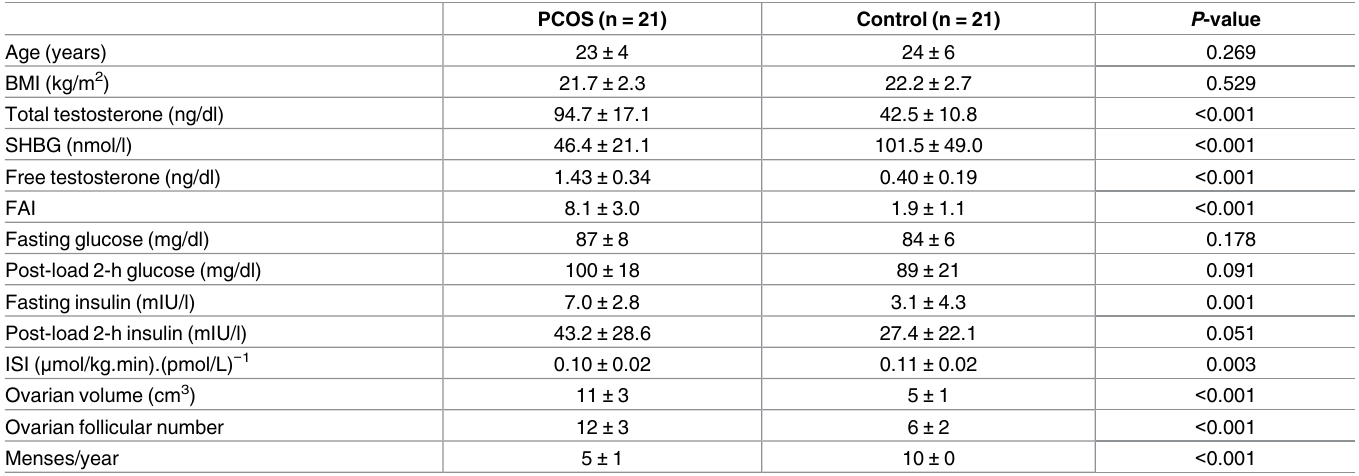
Table 1. Clinical and biochemical characteristics of women with PCOS and control subjects.